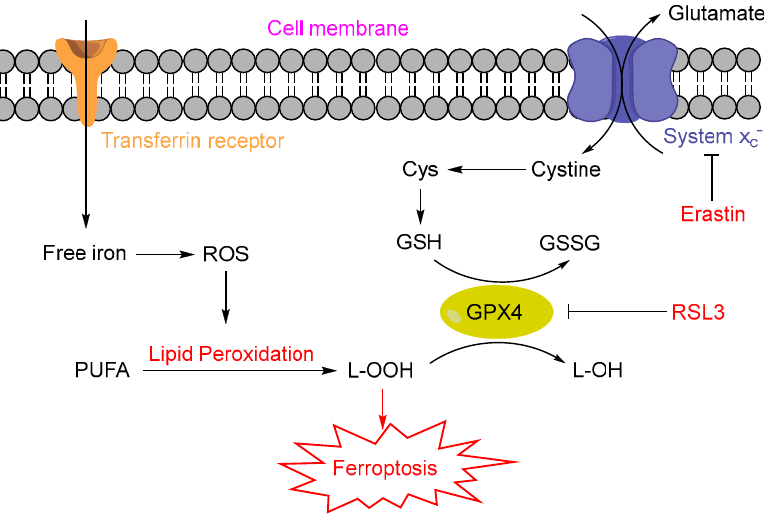
Figure 1. A brief illustration for the roles of iron, reactive oxygen species and biothiols in the development and redox regulation in ferroptosis. Abbreviations: Cys, cysteine; GSH, reduced glutathione; GSSG, oxidized glutathione; GPX4, glutathione peroxidase 4; ROS, reactive oxygen species; PUFA, polyunsaturated fatty acid; L − OOH, lipid peroxides; L − OH, lipid alcohols.